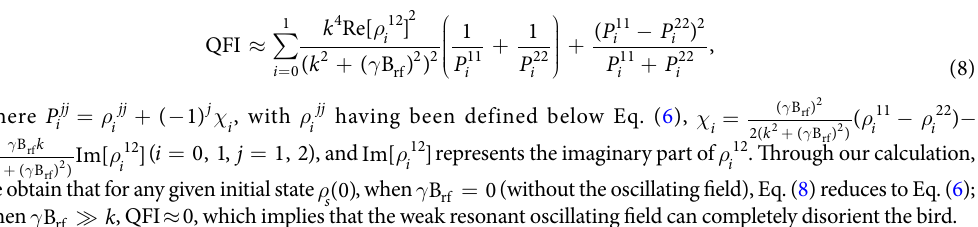
T (blue dotted line)), and with the oscillating field 0